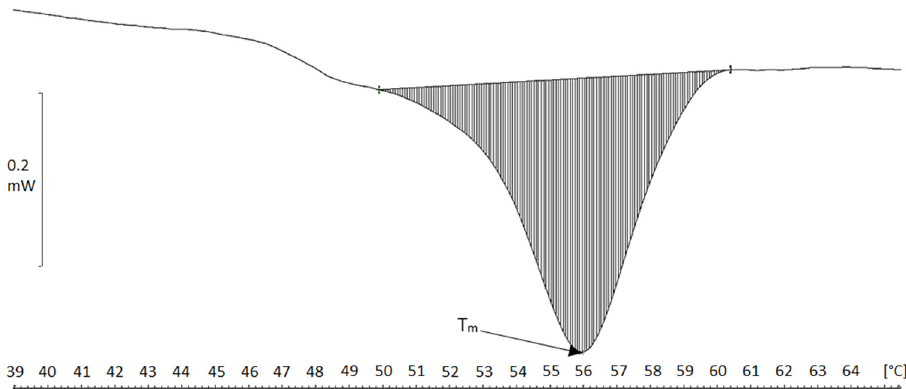
Figure 2. DSC thermogram of atelocollagen fibers in neutral solution (obtained after pretreatment of the raw material in MgCl 2 solution).